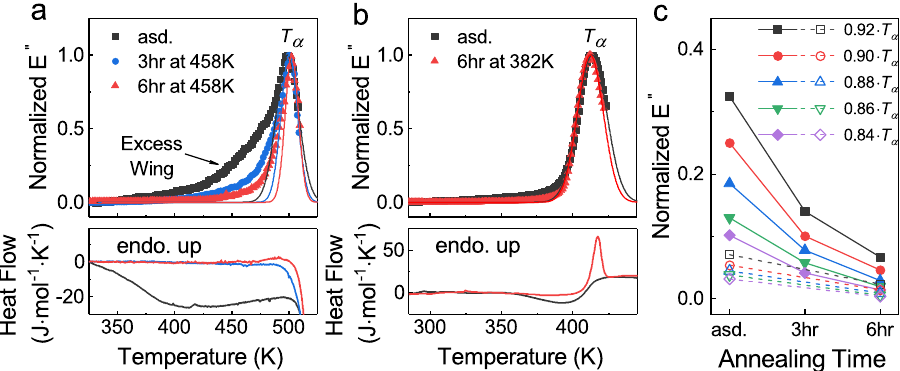
Fig. 1 | The β -relaxations characterized by powder mechanical spectroscopy (PMS).a Thenormalizedlossmoduli E ′′ aremeasuredat1Hzforas-deposited(asd.) PCM Ge 15 Sb 85 and the samples after annealing at 0.92· T α ≈ 458K for 3 and 6h. The as-deposited sample shows a pronounced excess wing in E ′′ , indicating a β -relaxation process. The excess wing is diminished uponannealing. b Normalized